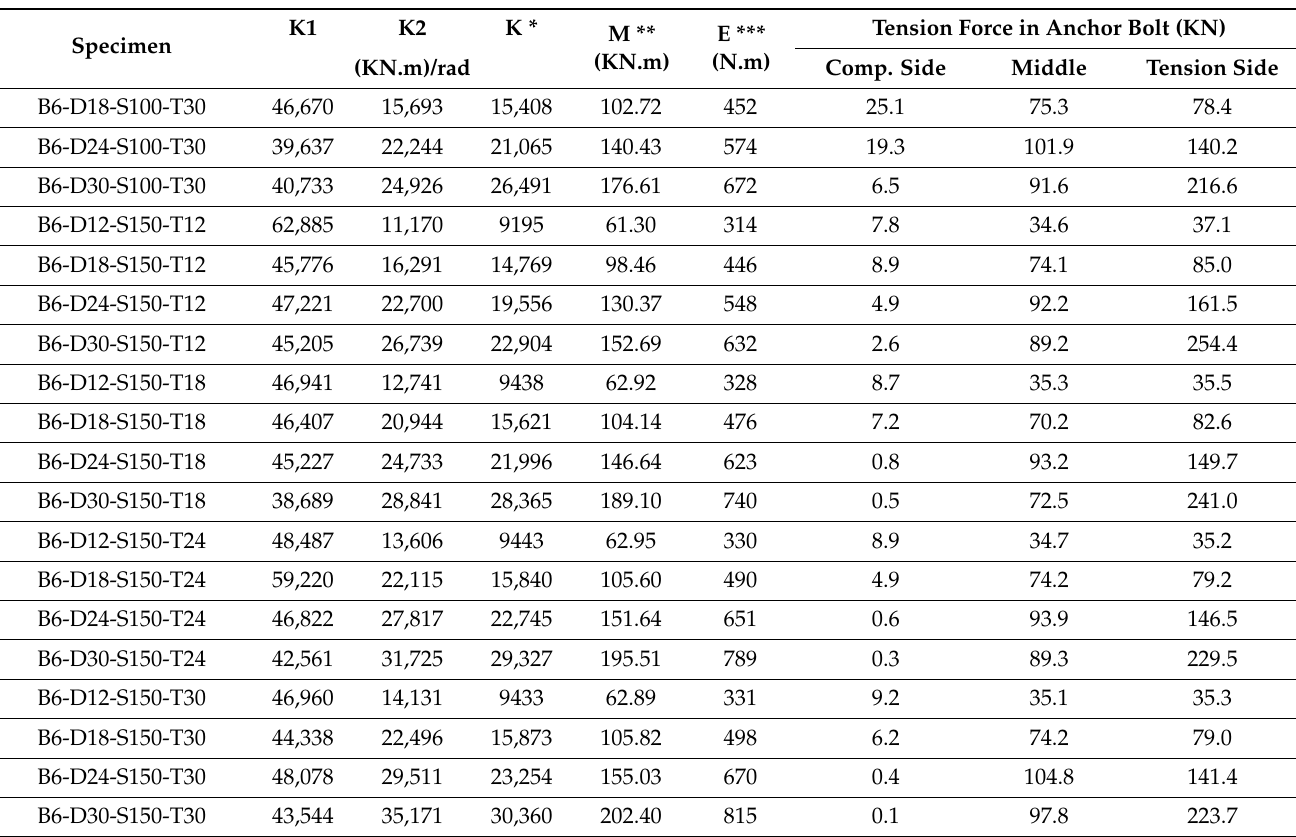
Figure 9. Schematic for calculating the ( a ) rotation θ = δ /H, ( b ) rotational stiffness K = M/ θ , and ( c ) moment and energy at certain value of rotation.